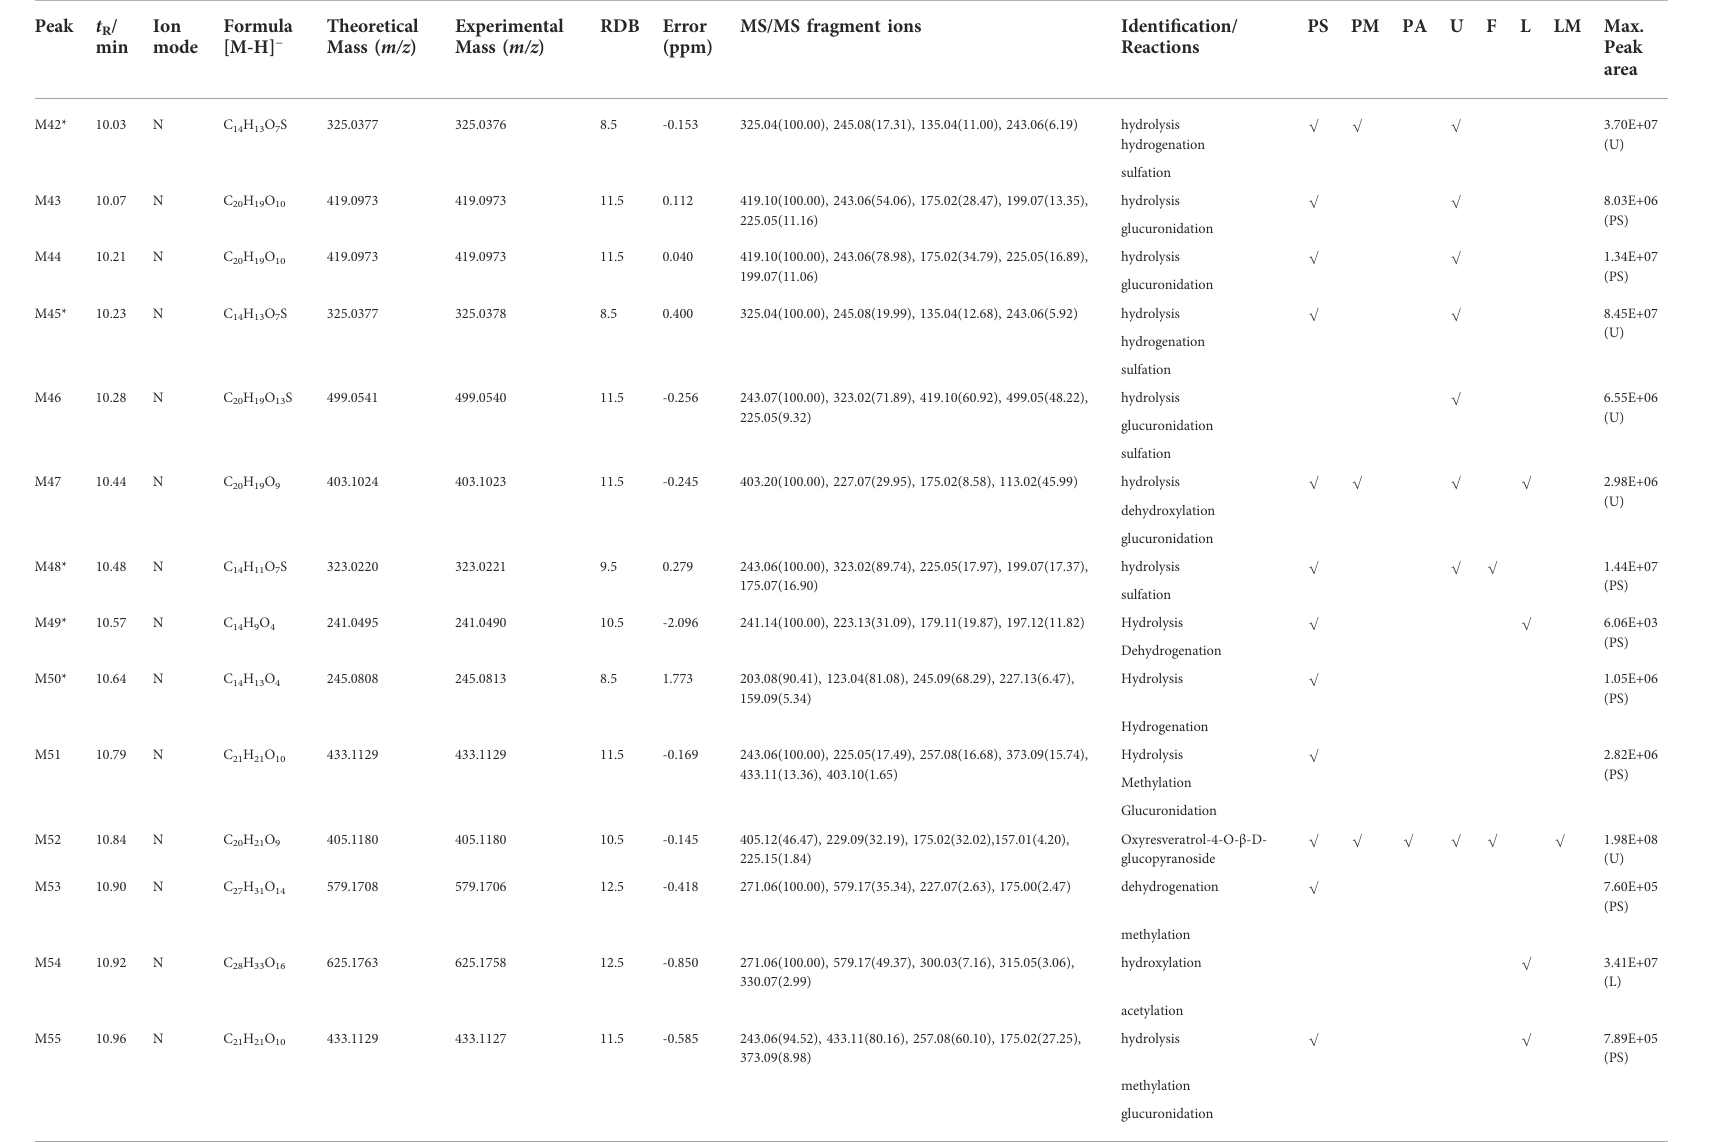
TABLE 1 ( Continued ) Summary of mulberroside A metabolites in vivo and in vitro of